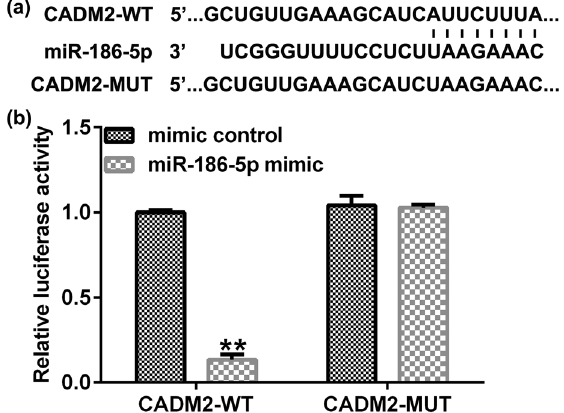
Figure 6: Correlation between miR - 186 - 5p and CADM2. ( a ) StarBase analysis predicted the relationship between miR - 186a - 5p and CADM2. ( b ) The association between miR - 186 - 5p and CADM2 was veri fi ed via the dual - luciferase reporter assay. ** P < 0.01 vs mimic control. miR, microRNA; CADM2, cell adhesion molecule 2.